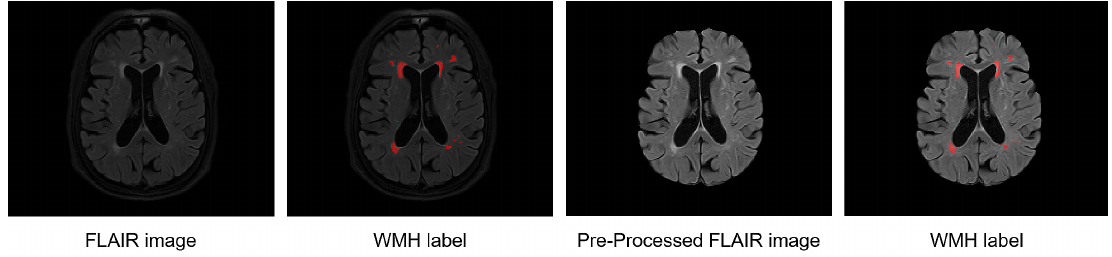
Figure 3. Example of WMH labels on a raw FLAIR MRI and WMH labels on the preprocessed FLAIR